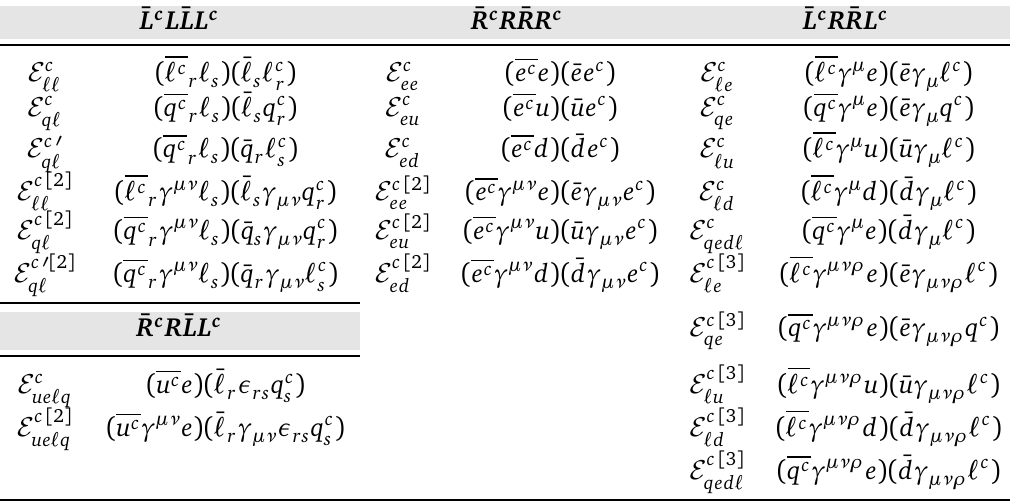
Table 9: Semileptonic and leptonic evanescent operators with four fermions featur- ing charge conjugation. We use the shorthand notation γ µ 1 ... µ n ≡ γ µ 1 ... γ µ n with no